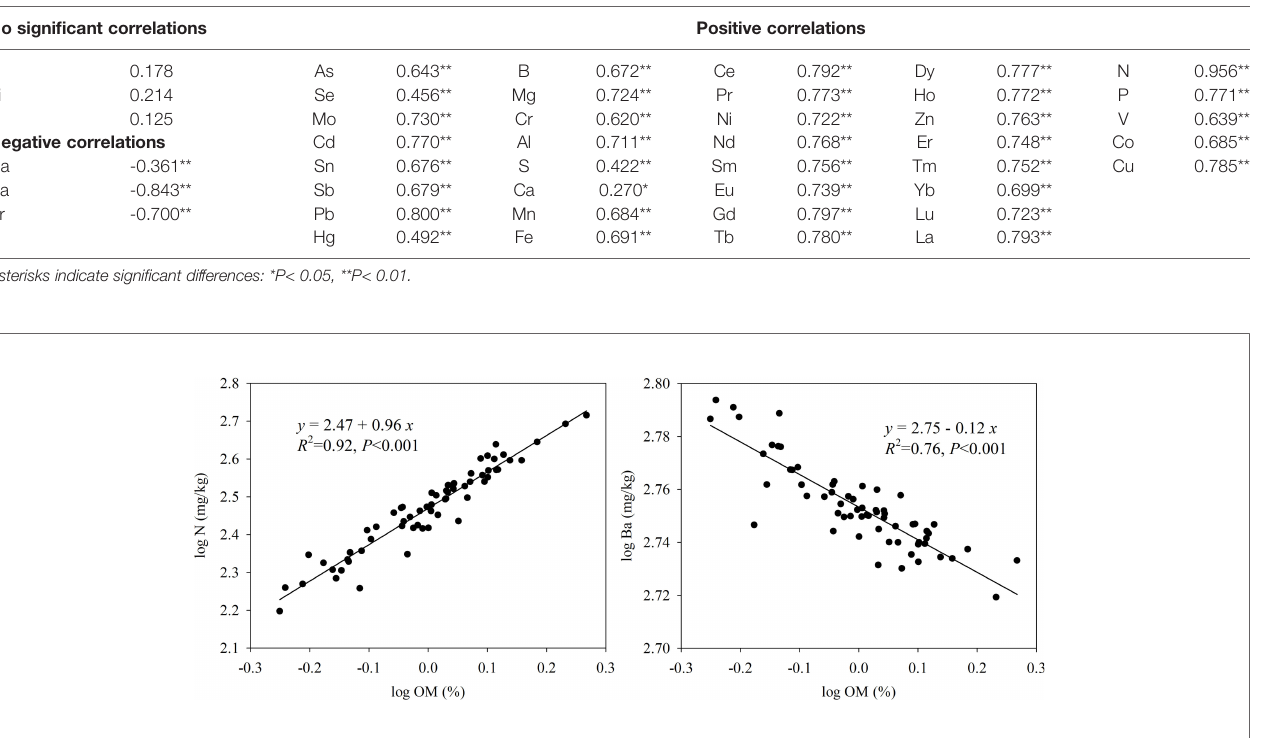
FIGURE 3 | Positive (N) and negative (Ba) correlations between elements and soil organic matter.